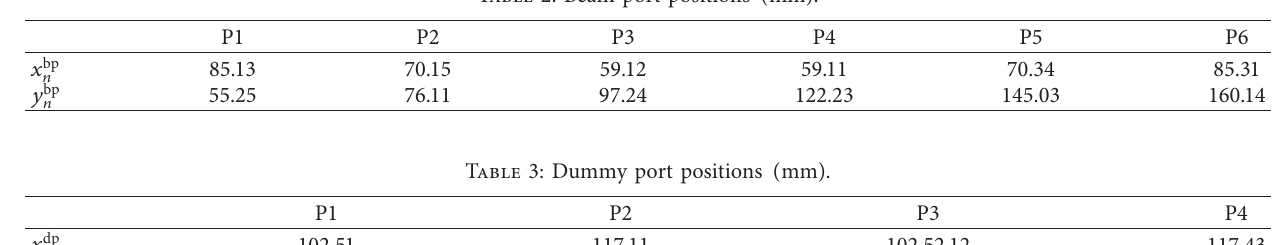
Table 2: Beam port positions ( mm ) .